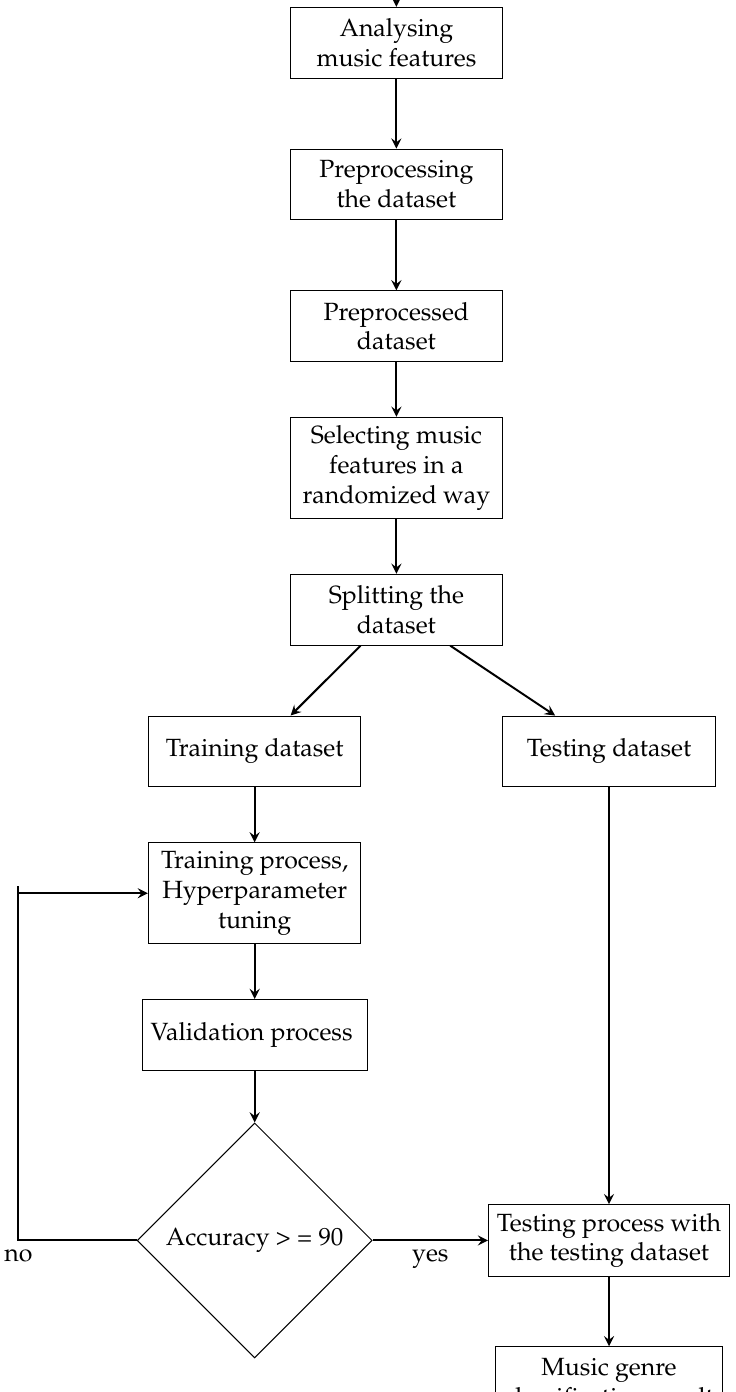
Figure 1. Flow of the investigation